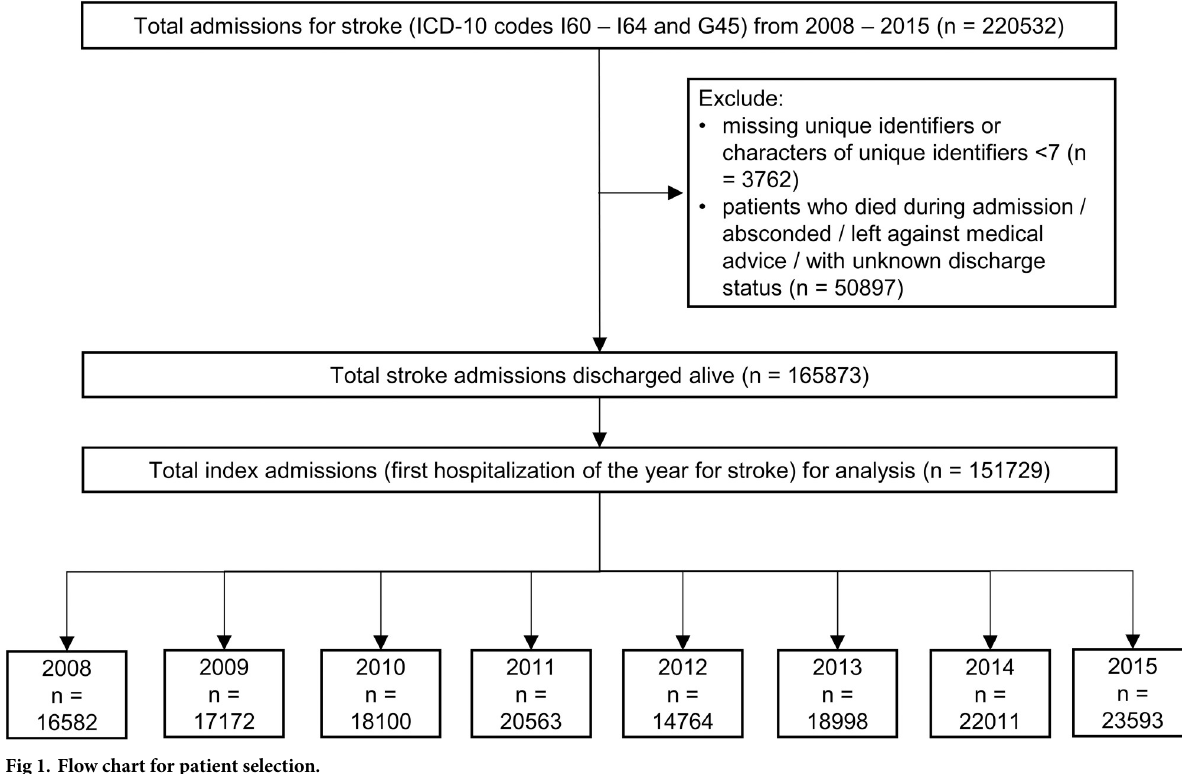
Fig 1. Flow chart for patient